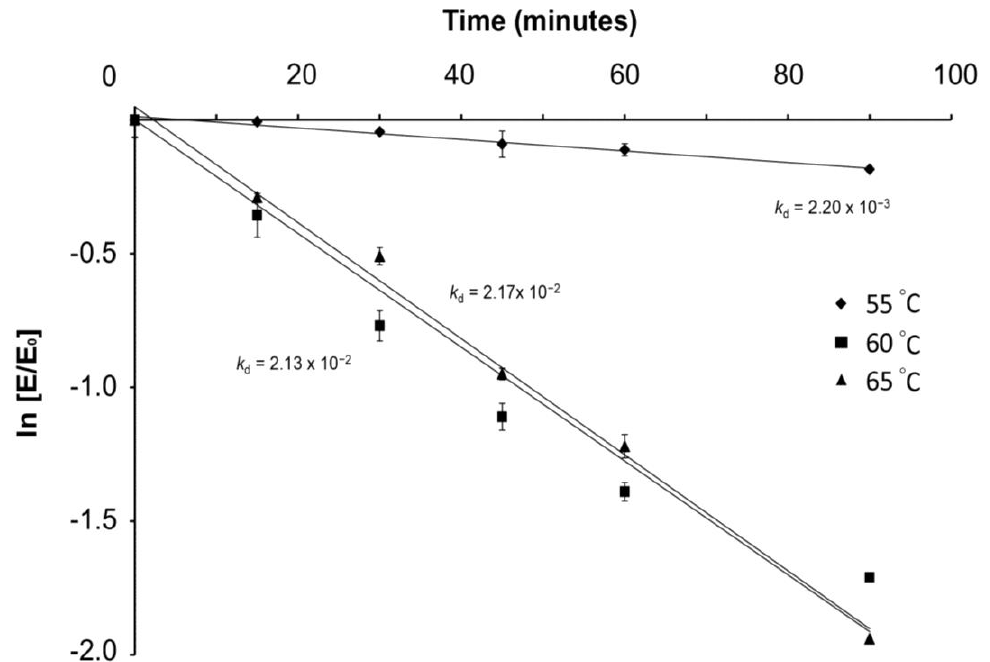
Figure 3. Thermal deactivation of crude GA extract at (  ) 55 °C, (  ) 60 °C and (▲) 65 °C over 90 min at pH 5.5. Experiments were duplicated. The mean values are plotted and the standard errors were